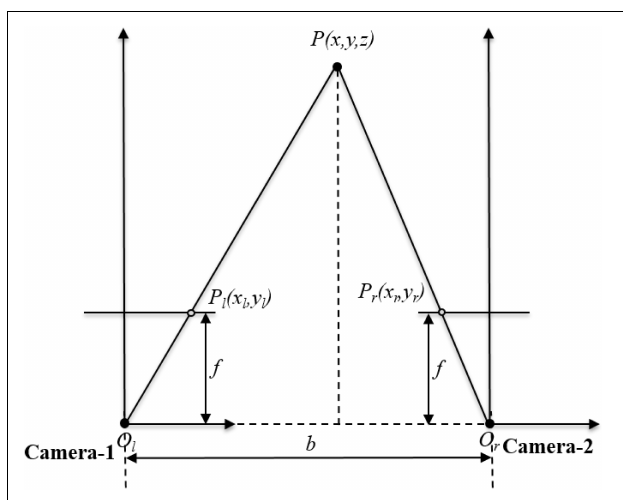
FIGURE 4 | The parallel structure of the binocular vision